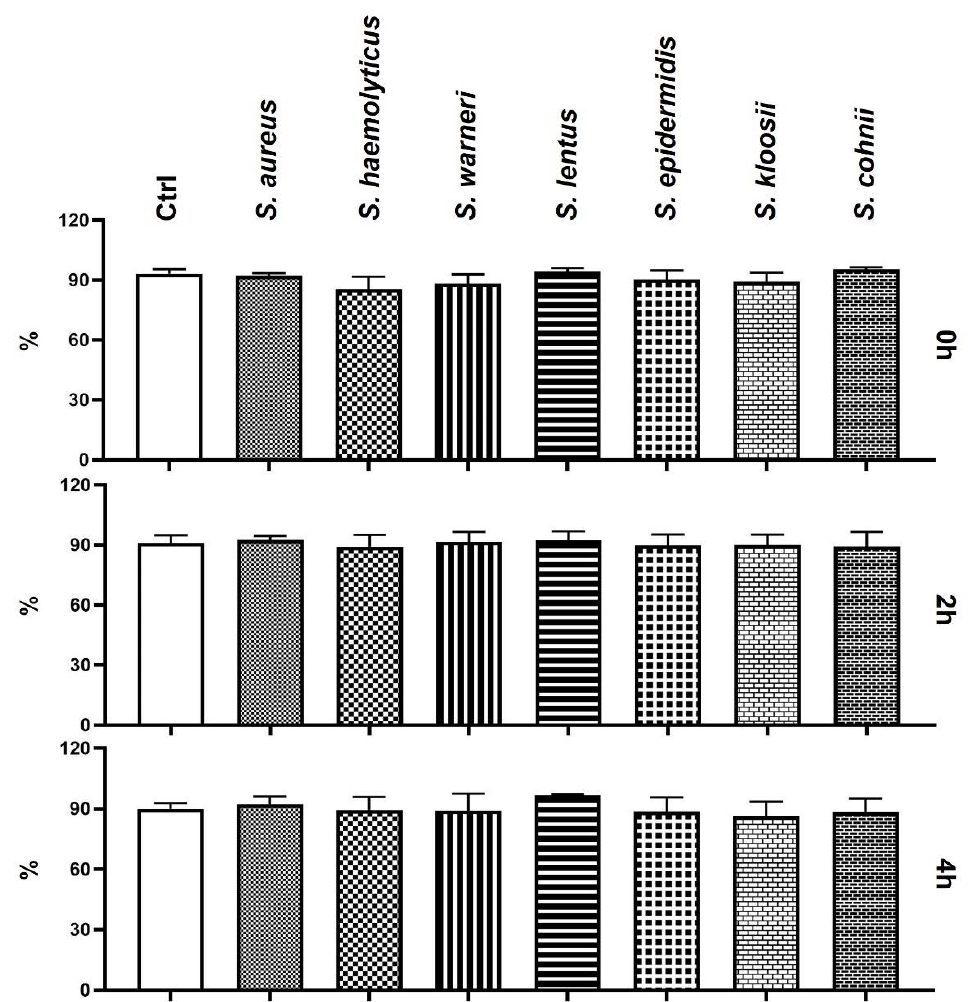
Figure 2. Changes in plasma membrane integrity during the 4-h bacteria/sperm co-incubation in vitro at 37 °C. Each group treated with Staphylococcus species was compared with the Ctrl group with no added bacteria. Each bar represents the mean percentage of sperm cells with intact plasma membrane ± S.E.M. Five individual experiments were performed to obtain these data.